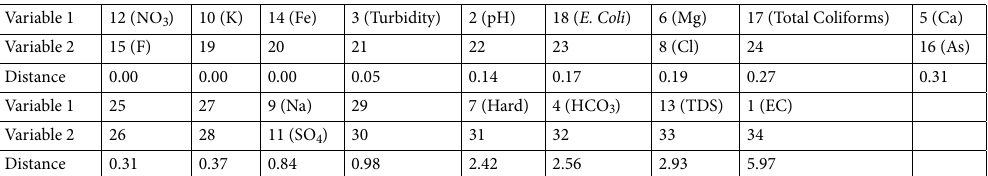
Table 3. Distance between two variables/clusters.